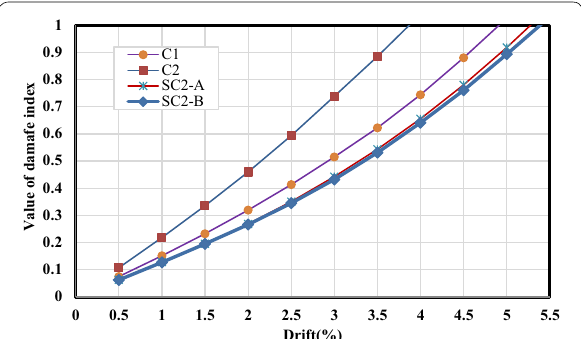
Fig. 24 Damage index versus ductility in the specimens.